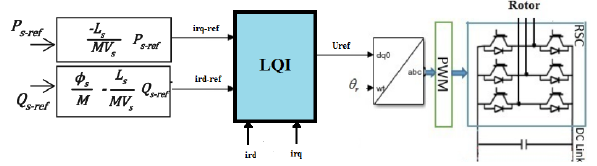
Figure 4. Available